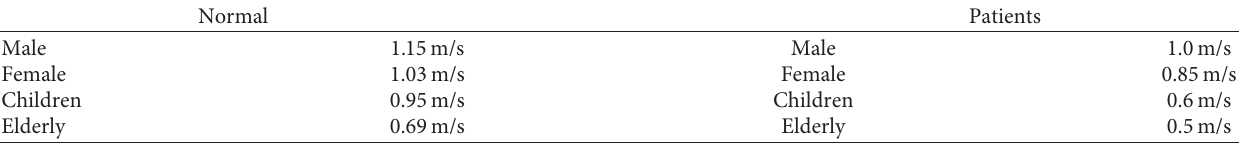
Table 17: Evacuation speed of different pedestrians.